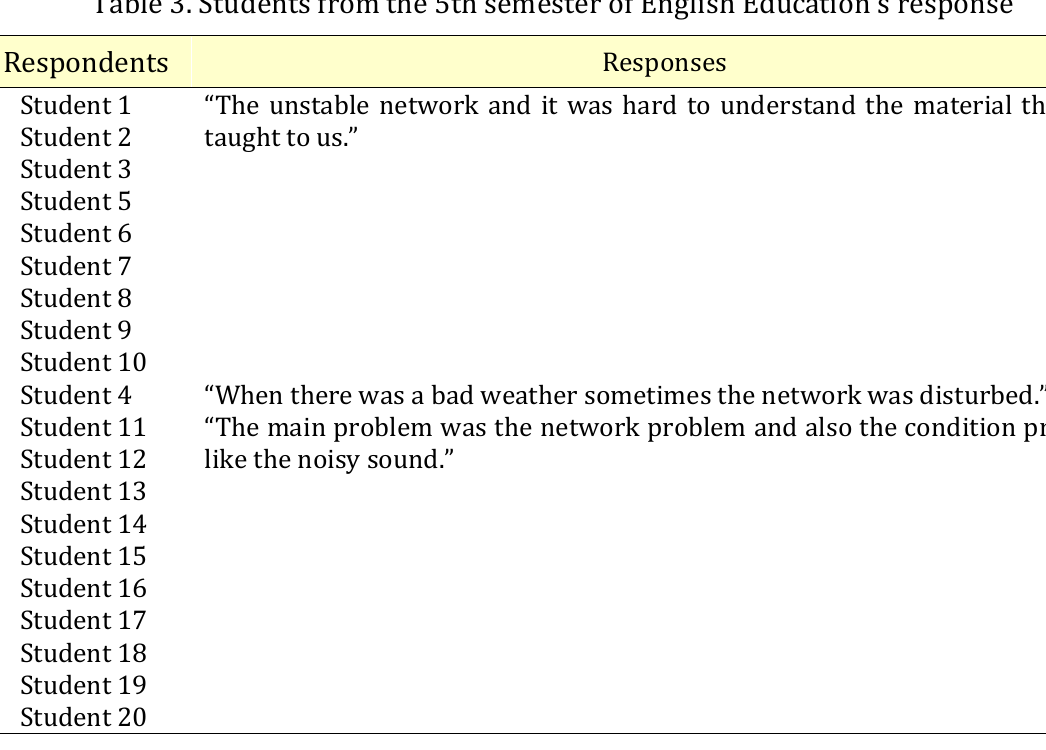
Table 3. Students from the 5th semester of English Education’s response